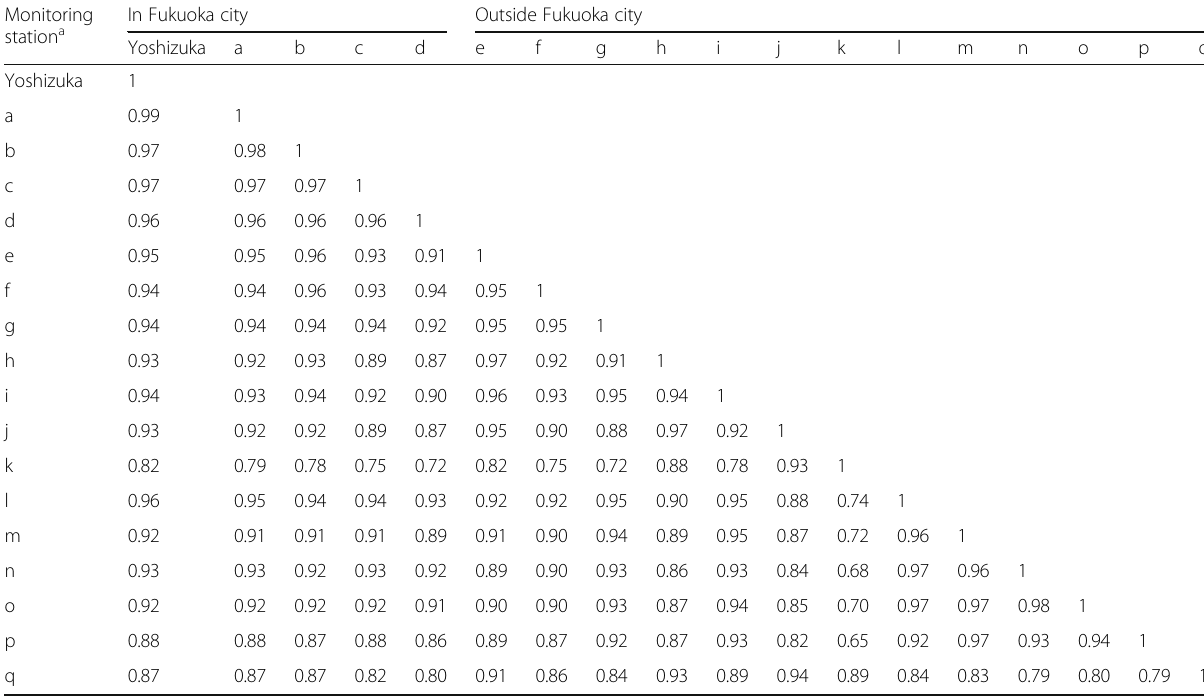
Fukuoka, 2014 Monitoring station